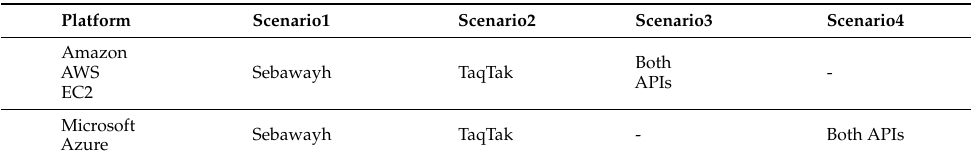
Table 5. The experimental